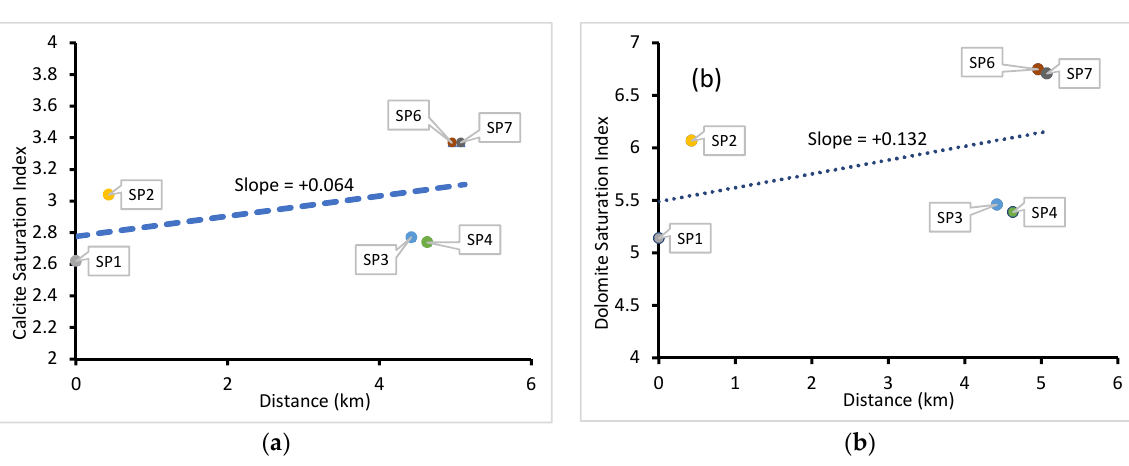
Figure 13. Variation of saturation indices for calcite ( a ) and dolomite ( b ) along the flow path.